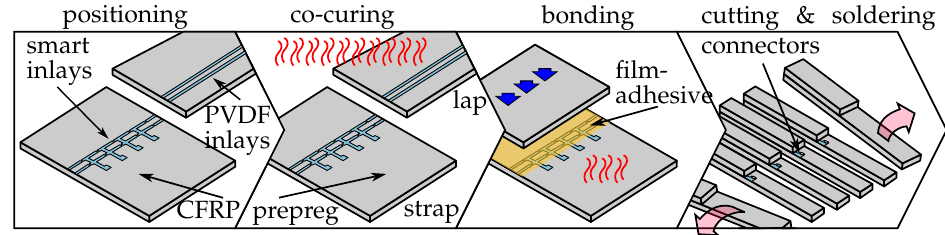
Figure 6. CLS specimen preparation inspired by the co-curing process developed by Löbel [39]. The adherends were made of 16 plies Hexply 8552/IM7 (12K) unidirectional prepreg 239